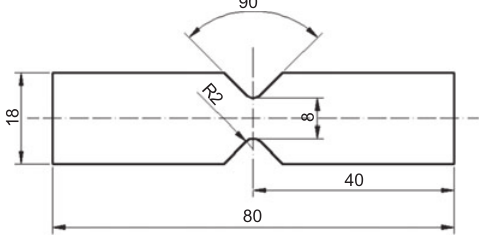
Figure 4 Photograph and structure of 2.5D (shallow bend-joint) perform.